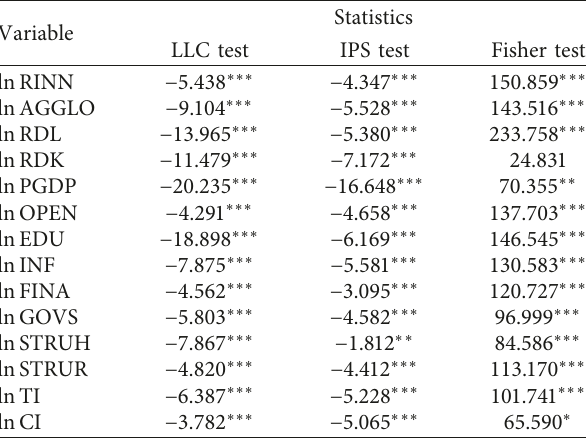
Table 2: Unit root test